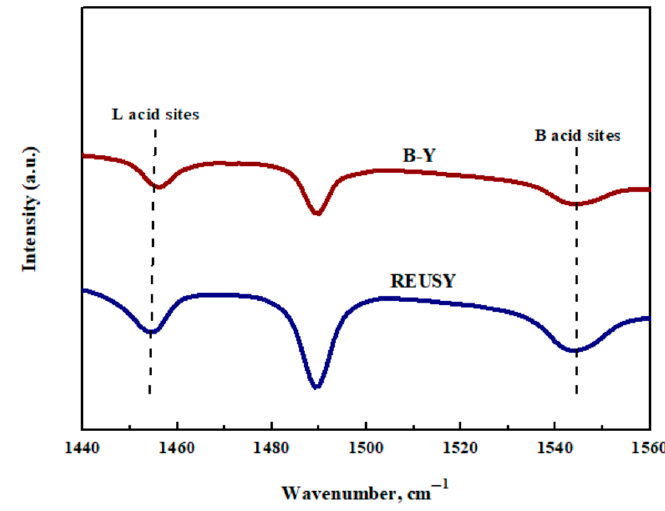
Figure 3. Py-FTIR spectra of REUSY and B-Y. Table 2. Physicochemical properties for REUSY and B-Y zeolites.